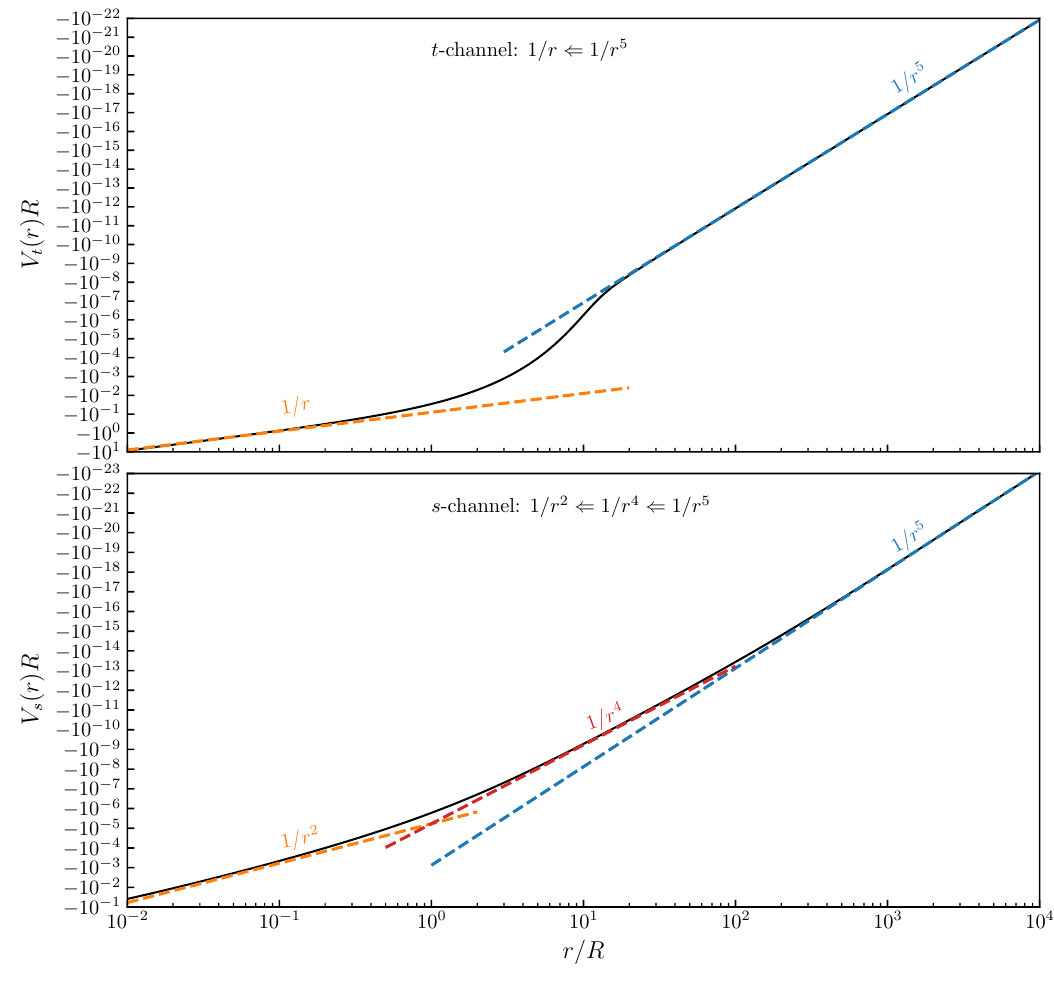
Figure 3 . The evolution of the t -channel (upper panel) and s -channel (lower panel) effective potentials. In the long-range limit, both of the potentials decrease as 1 /r 5 , while in the short-range limit, they exhibit 1 /r , 1 /r 2 , or 1 /r 4 behaviors, depending on the UV completion of the contact interactions and relevant mass scales — see the text for further details and discussions. The length unit R is determined by m and/or m according to eqs. (3.13) and φ χ